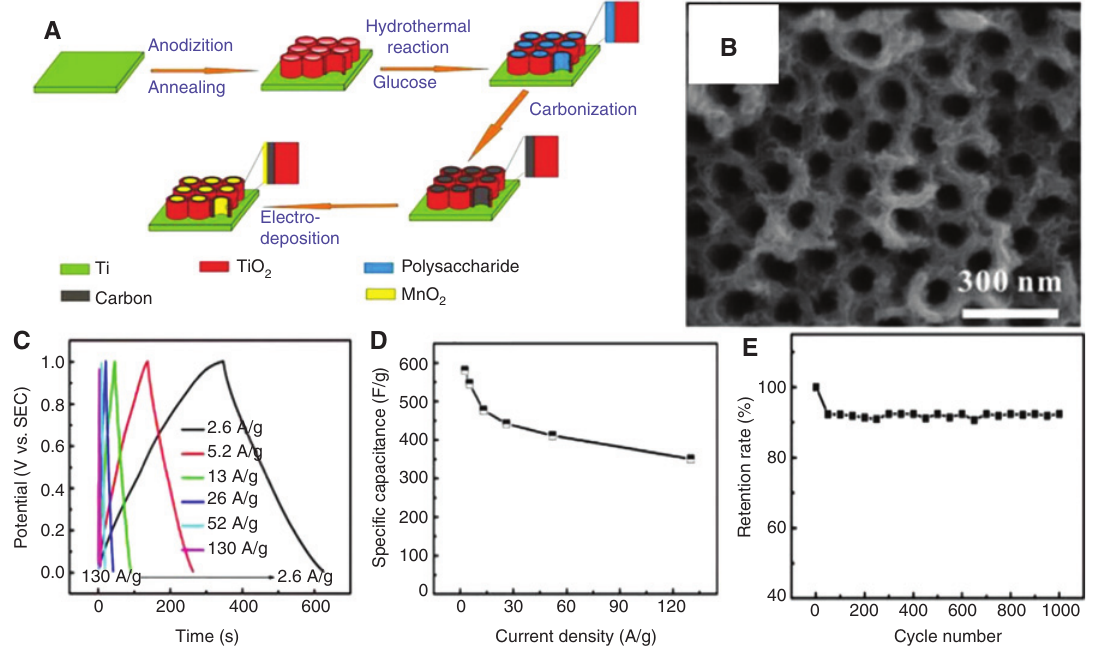
-TiO /C NTAs (A). SEM image of MnO -TiO /C NTAs (B). GCDs (C) and gravimetric 2 2 2 2 -TiO /C NTAs. (E) Cycling stability of the MnO -TiO /C NTAs at a 2 2 2 2